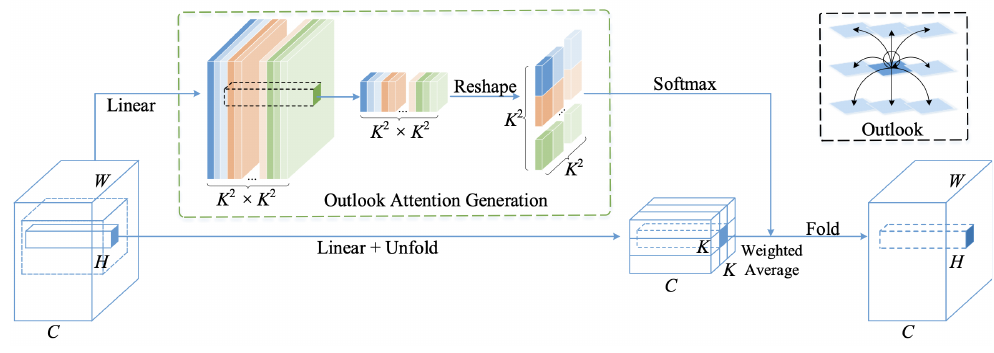
Figure 6. Detailed illustration of the outlook attention from